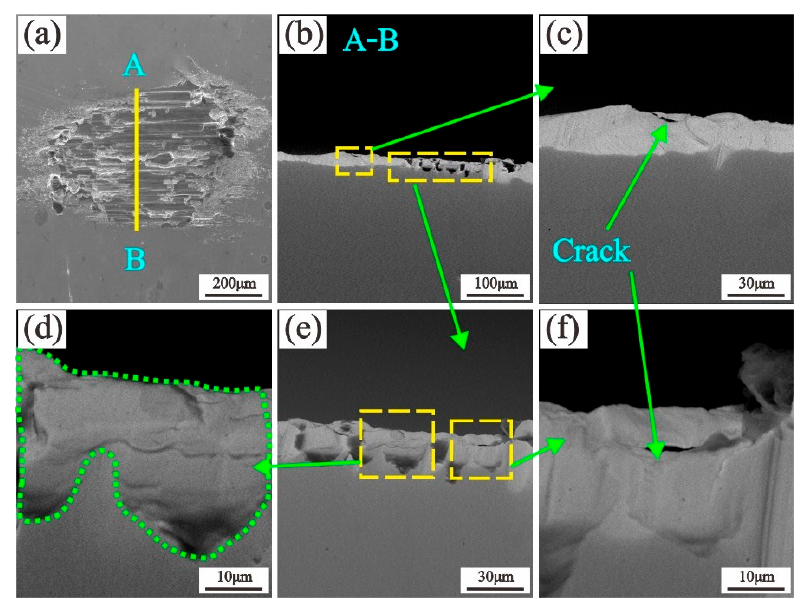
= 450 ◦ C; F = 10 N; D = 50 µ m.